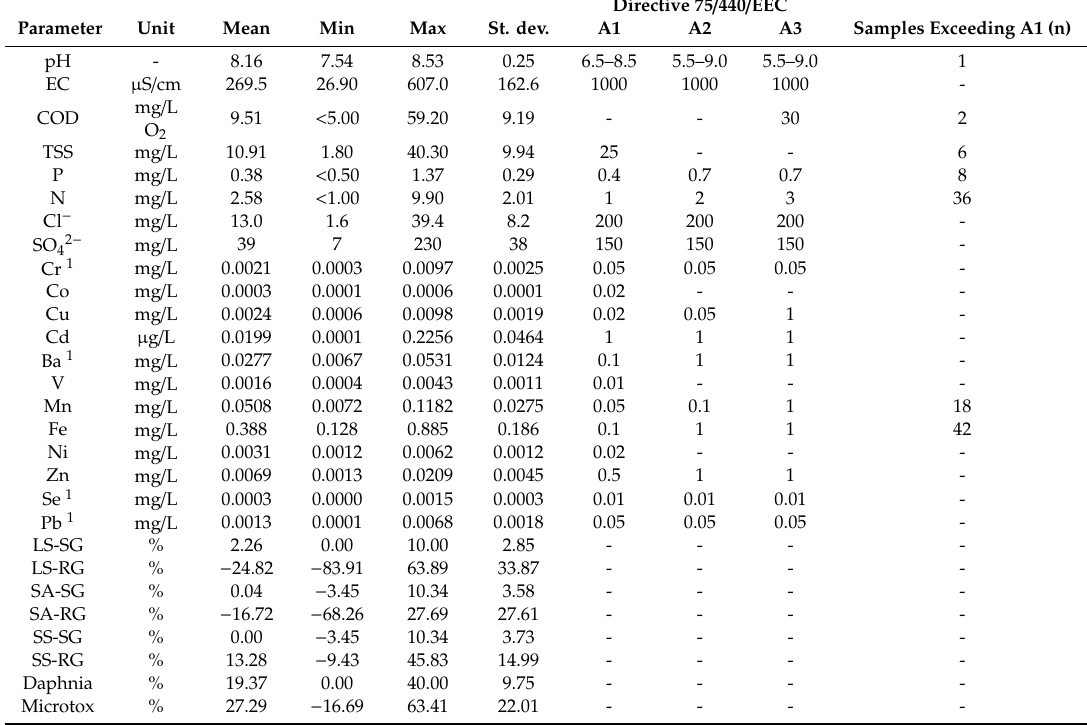
Table 2. Basic statistics of water quality parameters in surface waters ( n = 42), guide values for surface water intended for the abstraction of drinking water according to Directive 75 / 440 / EEC and number of samples exceeding the A1 guide